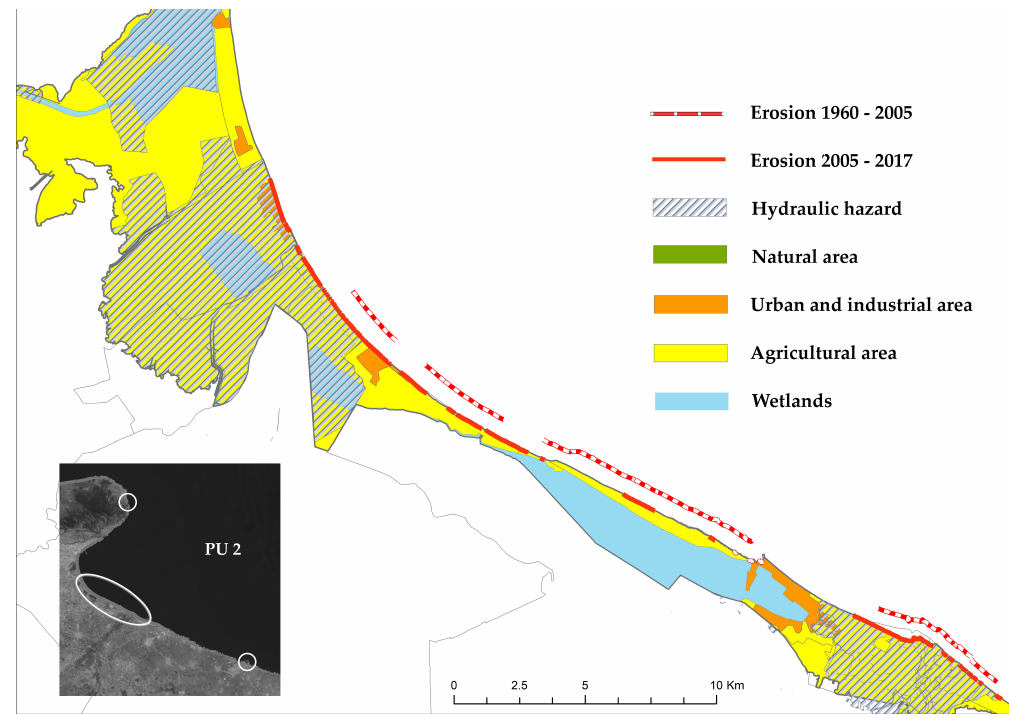
Figure 6. Land cover, shoreline erosion and river flooding areas in a selected area within